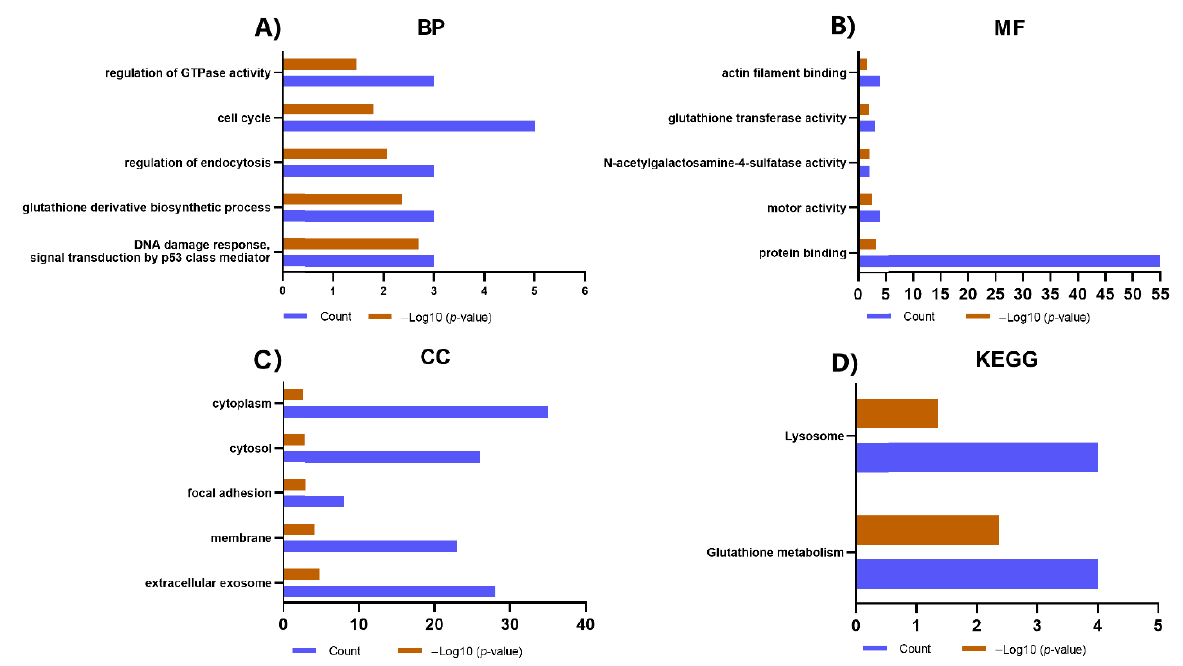
Figure 3. GO and KEGG analysis of proteins identified exclusively in the IPF-2 and IPF-1 groups. ( A ) The main enriched terms for BP. ( B ) The main terms enriched for MF. ( C ) The main enriched terms for CC. ( D ) Top enriched terms for KEGG pathways. If there were more than five enriched terms for one of the categories, the five most representative ones were selected according to the p value.